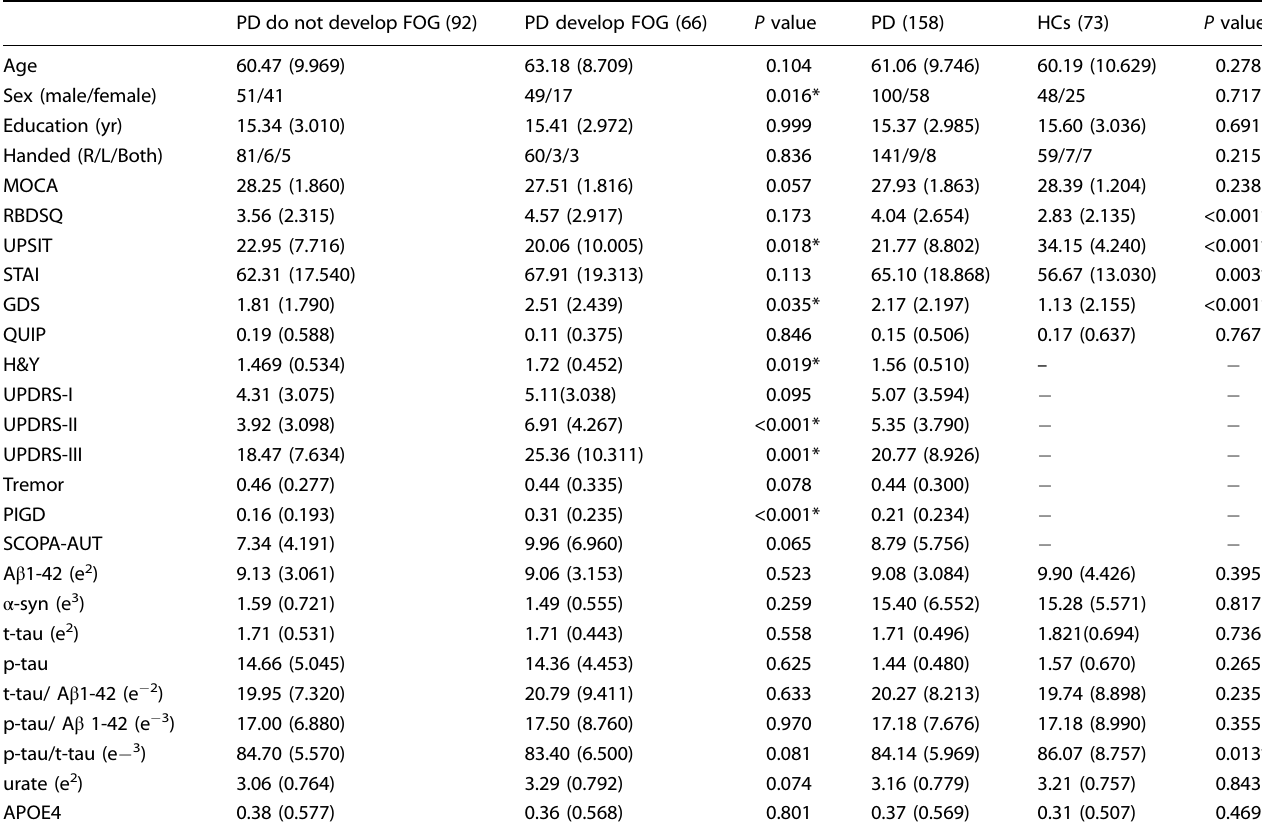
Table 1. Baseline demographics, clinical and laboratory characteristics of all participants.